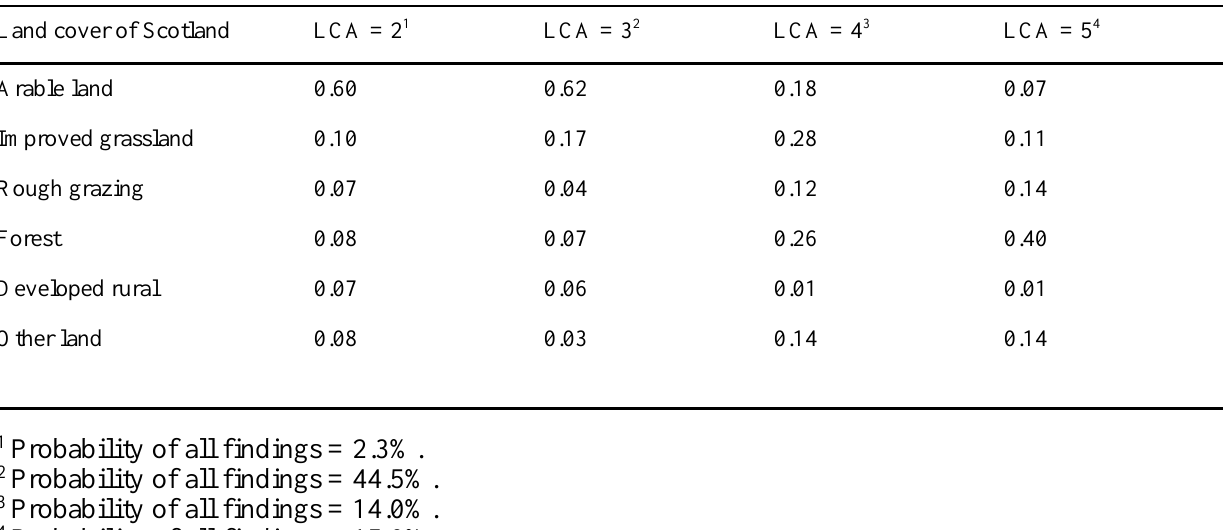
1 Probability of all findings = 2.3%.